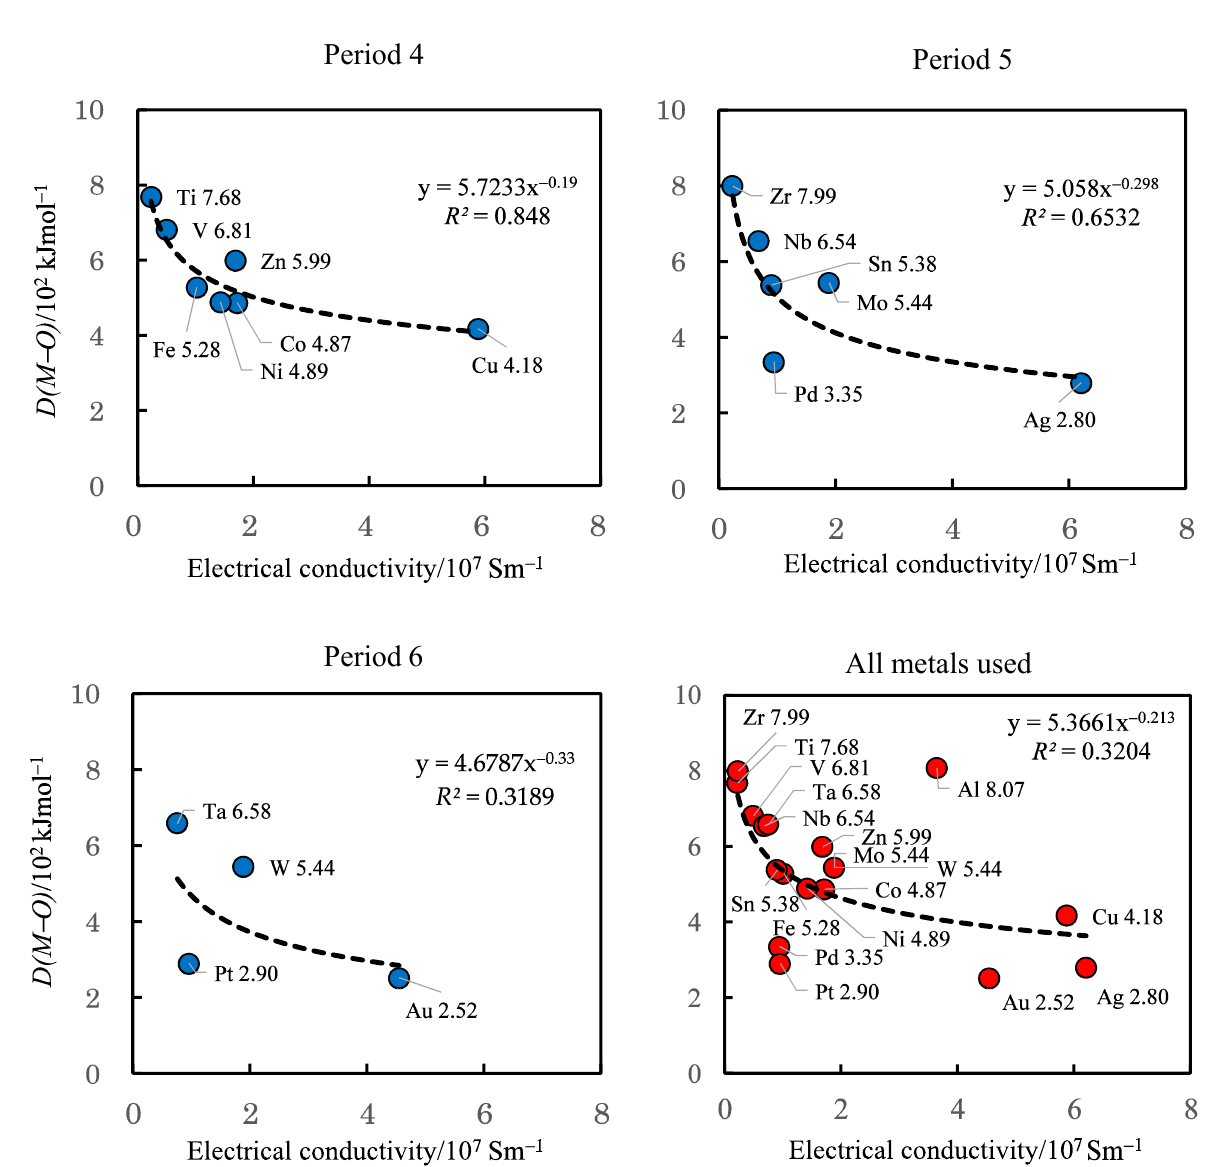
Figure 14. The plots of D(M–O) values against electrical conductivities for metals in periods 4, 5, and 6, and all metals used.